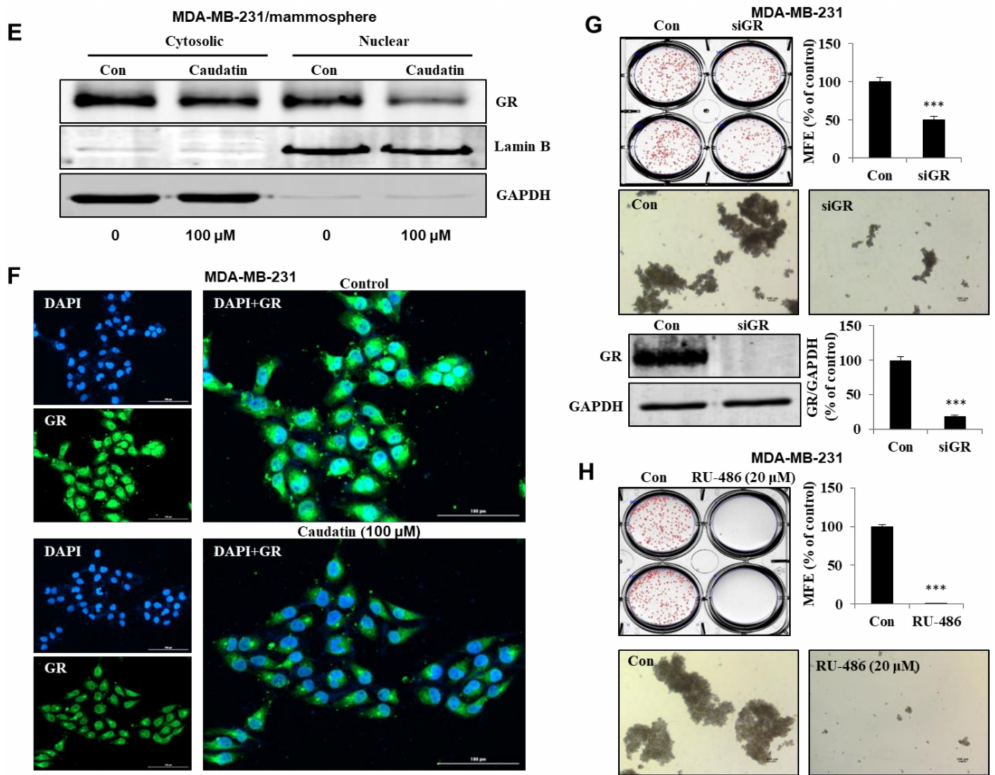
Figure 6. Caudatin inhibits the glucocorticoid receptor (GR) signal through the ubiquitin (Ub)-dependent degradation of GR. ( A ) The expression level of GR in the total protein of MDA-MB-231-derived mammospheres was measured after treatment of the mammospheres with caudatin for 48 h using western blot analyses. ( B ) After treatment with caudatin, the transcriptional expression of the GR gene was detected in mammospheres by real-time reverse transcription- quantitative polymerase chain reaction (RT-qPCR) using specific primers. β -actin was used as an internal control. ( C ) Mammospheres incubated with caudatin were lysed for immunoprecipitation (IP) with an anti-GR antibody, and western blot analysis was performed using anti-ubiquitin and anti-GR antibodies. ( D ) Mammospheres were incubated with caudatin and MG-132 (0.5 µ M) for 24 h and lysed for western blot analysis. ( E ) The expression level of GR in the cytosolic and nuclear protein fractions of MDA-MB-231-derived mammospheres was measured after treatment of the mammospheres with caudatin using western blot analysis. ( F ) Immunofluorescence (IF) analysis of GR (green) expression and localization in MDA-MB-231 cells under caudatin treatment was performed. ( G ) The e ff ect of knocking down GR expression using GR-specific siRNA on mammosphere formation was evaluated. ( H ) The e ff ect of RU-486, an antagonist of GR, on mammosphere formation was evaluated. The data are presented as the mean ± SD of three independent experiments. ** p < 0.01 and *** p < 0.001 versus the DMSO-treated control